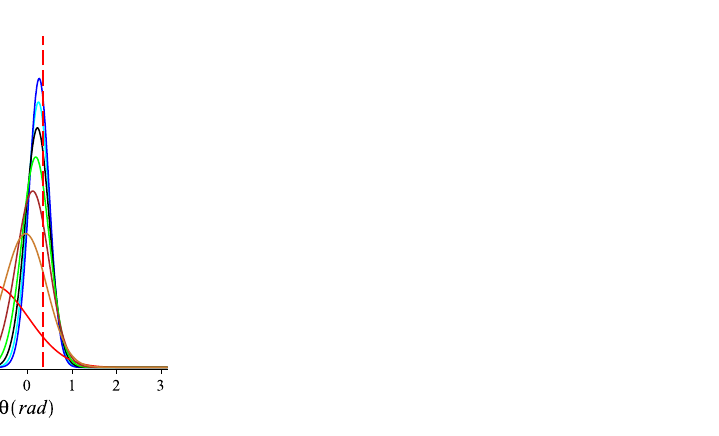
Figure 4. The probability density of the orientation of the free endpoint of the grafted structure with an even number of arms. The red, gold, brown, green, black, cyan, and blue are associated with the fixed value of the magnetic energy parameter, K B = 0,3,6,9,12,15,18, respectively. The other fixed = 12.5. The red dashed line is associated with n = 2, and l p parameters are: ω = π , φ µ = 0, φ B = π L 9 4 θ = π , which is also the value of φ B . 9